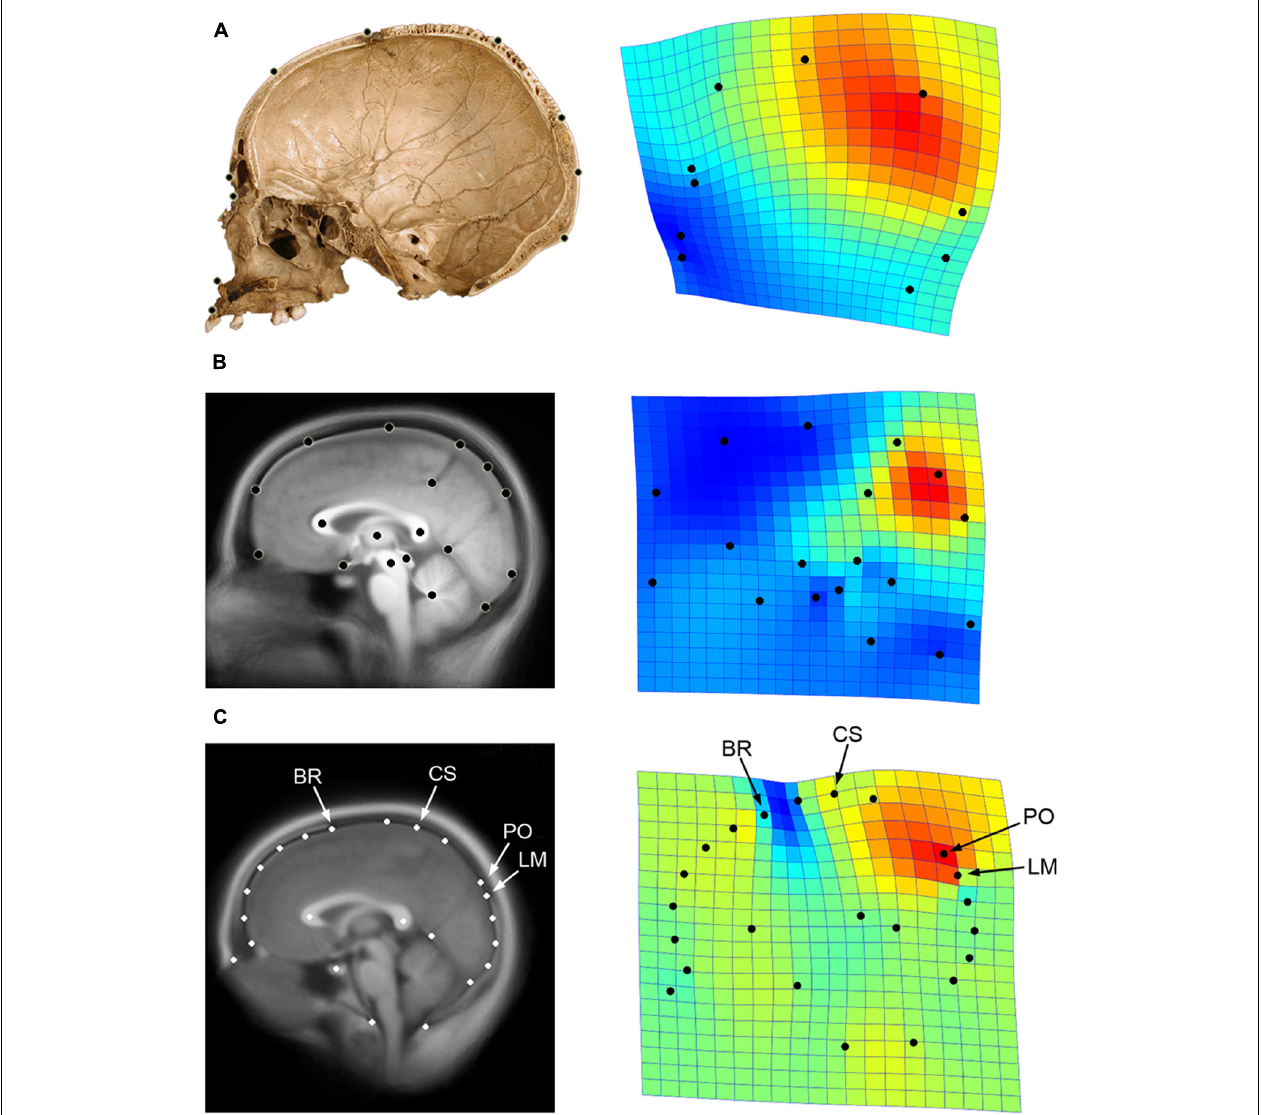
bregma (BR), and shifts the parieto-occipital sulcus (PO) away from lambda (LM).The geometrical configuration used in each analysis is shown on the left, while the first principal components of variation after Procrustes superimposition is shown on the right through thin-plate spline deformation grids and deformation map (red: dilation; blue: reduction; data computed using PAST 2.17c; Hammer etal., 2001). Here it can be seen that the same pattern is associated with modern human origin and evolution, modern human variation, and skull/brain